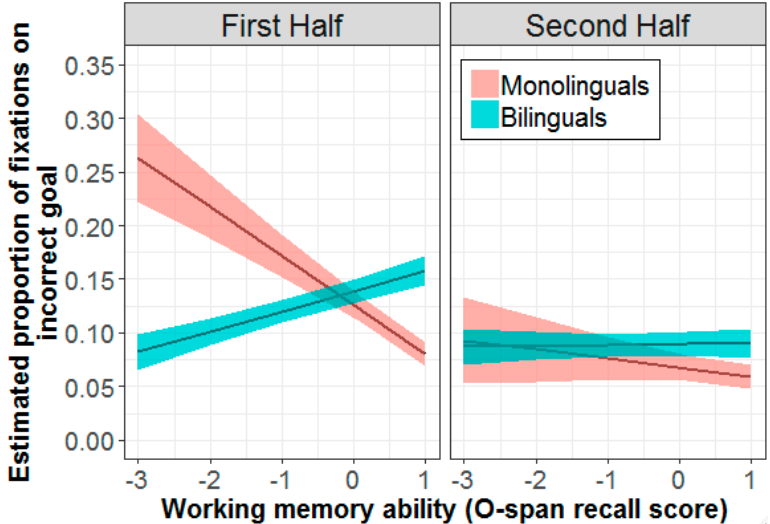
Figure 7. Estimated effect of working memory on incorrect-goal fixations in the first (left) and second (right) half of the experiment for bilinguals ( n = 23) and monolinguals ( n = 26). More positive values on the x -axis indicate higher O-span recall scores. Shaded areas indicate standard error of the mean.